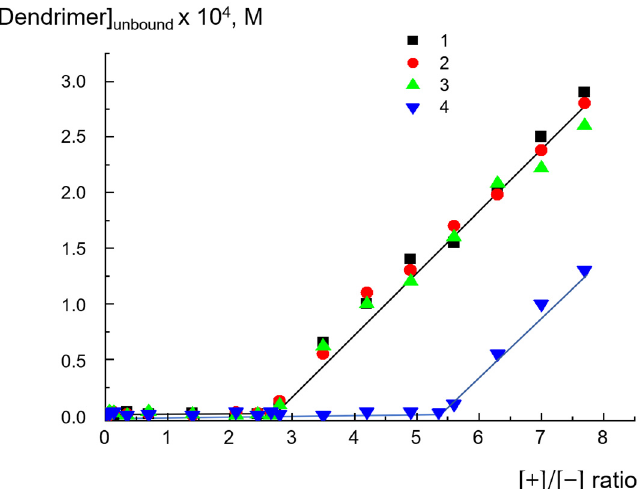
Figure 4. Dependence of concentration of unbound dendrimers on ratio of ionic groups [+]/[ − ] for D 350+ (1), D 229+ (2), D 215+ (3), and D 16+ (4), where [+] is the molar concentration of the pyridinium groups of dendrimers, and [ − ] is the molar concentration of negatively charged cardiolipin headgroups. CL/Chol/DOPC liposomes, [CL] = 1.5 × 10 − 4 mol/L, total lipid concentration of 1 mg/mL. 10 − 3 M phosphate buffer, pH 7.2.